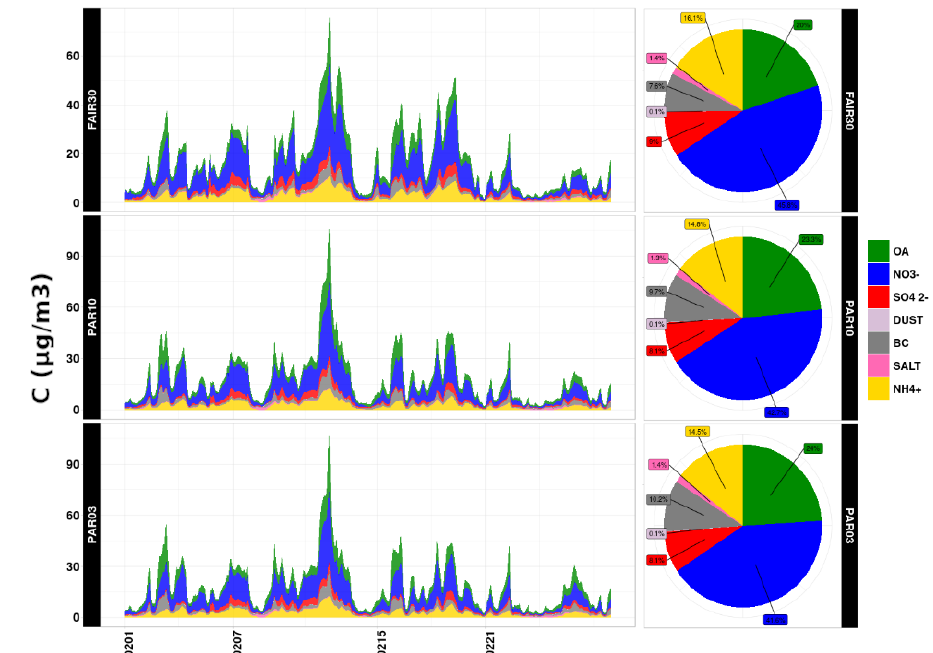
Figure 3. PM composition in the reference simulation as time series ( left ) and the average pie charts ( right ) showing three domains (each row one domain) in µ g · m − 3 . The plots are calculated using the average of stations common for all three